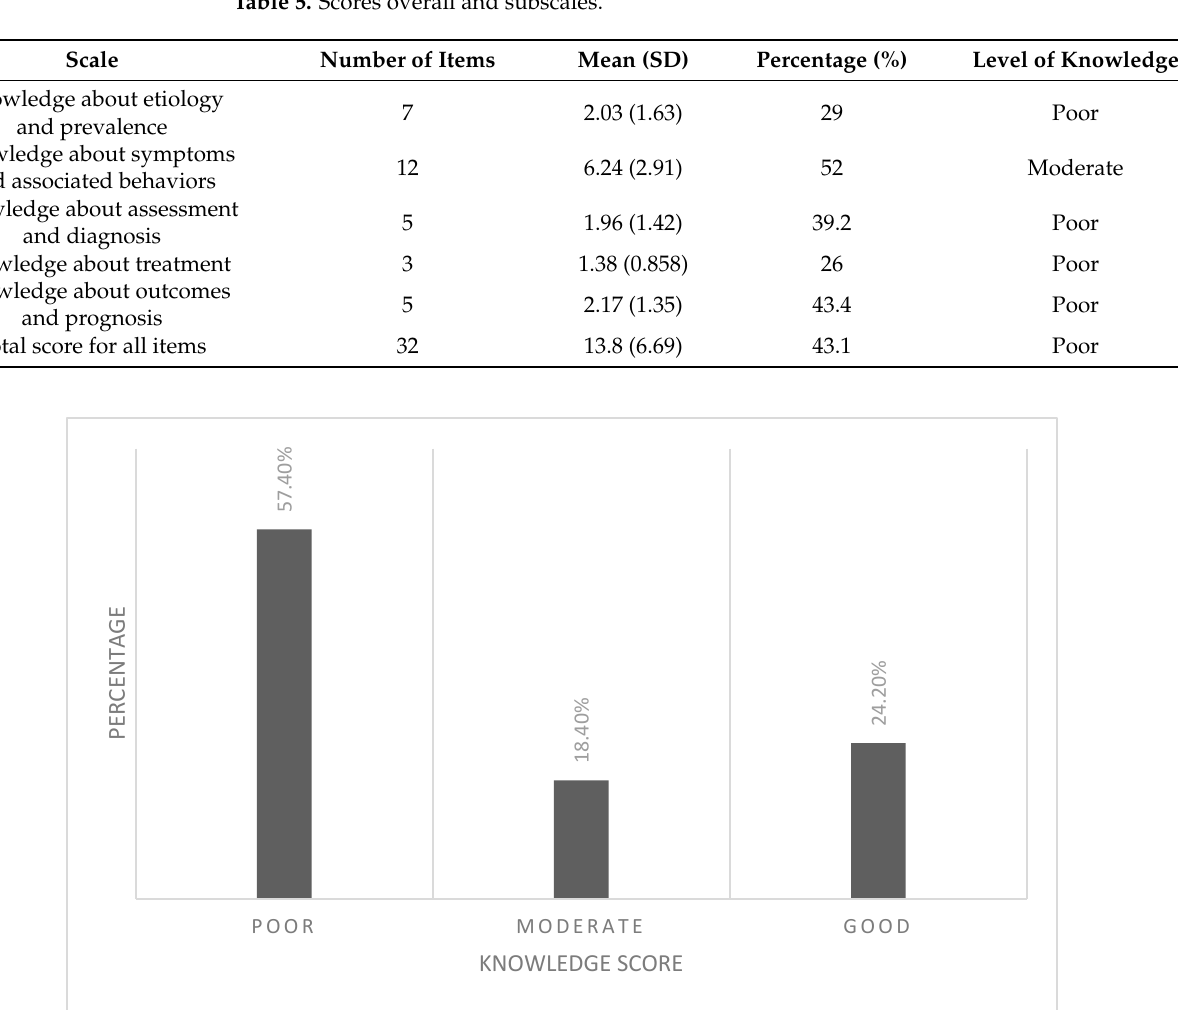
Figure 2. Participant’s knowledge score. Knowledge score < 50% = poor knowledge, 50–75% score = moderate knowledge, >75% score = good knowledge.